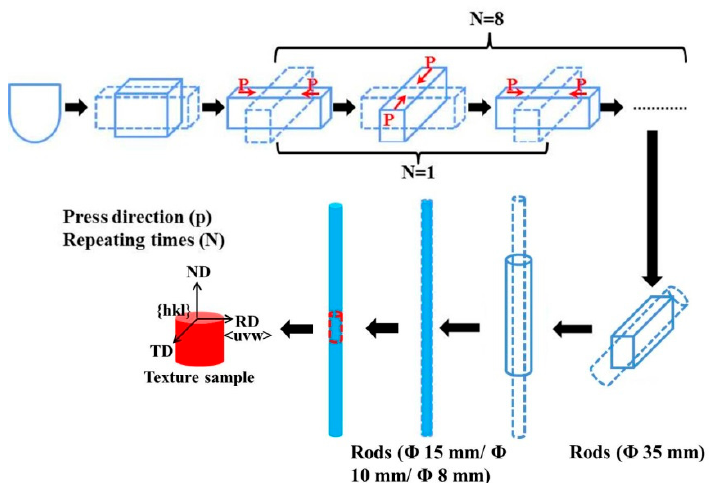
Figure 1. Schematic of the fabrication process of hot-forged rods and the orientations of the samples cut from the rods for texture measurements.